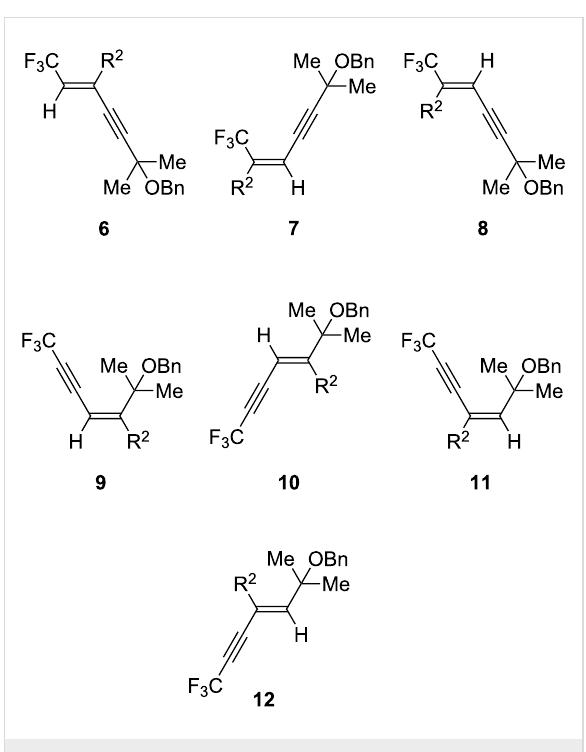
Figure 2: Regio- and